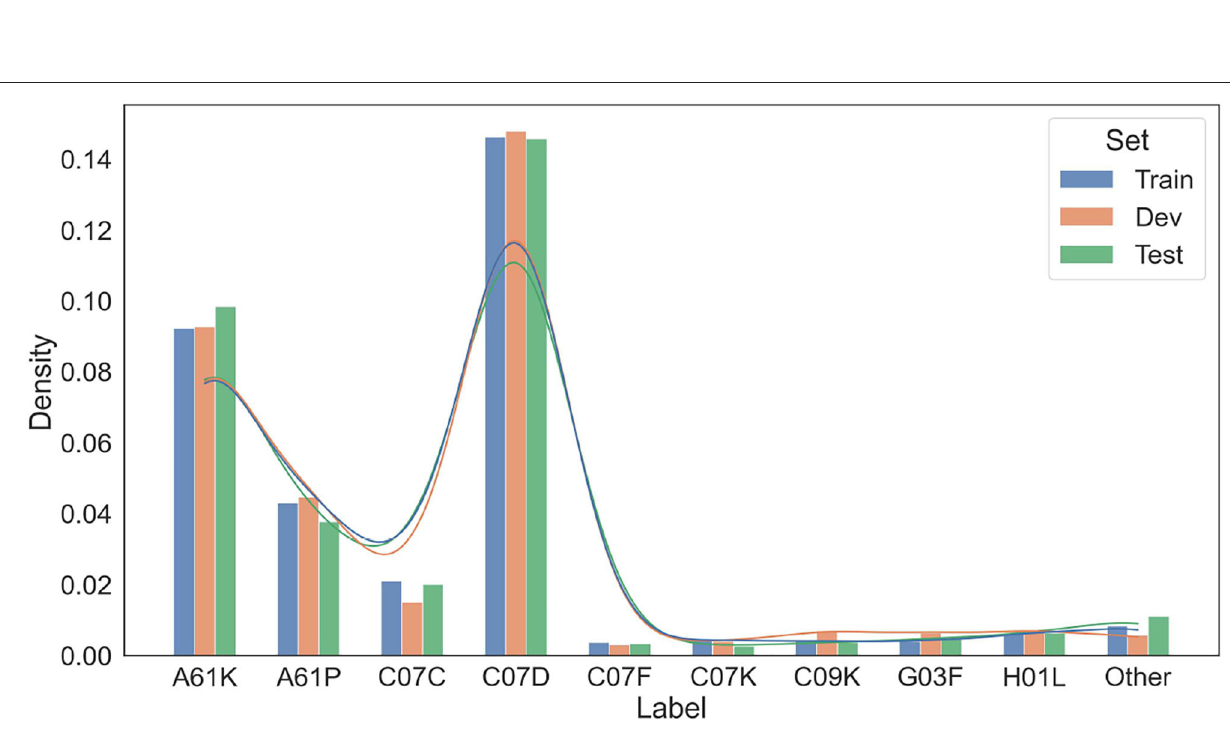
Frontiers in Research Metrics and Analytics |